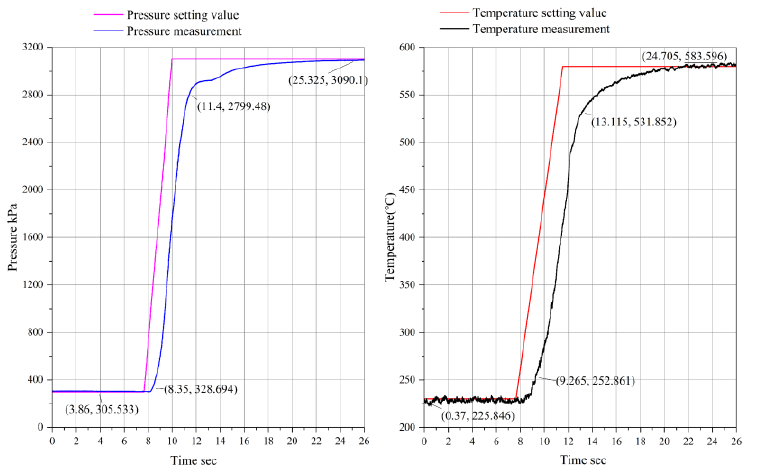
Figure 8. Compressor bleed air simulation of test piece one under the rise rates of 900 kPa/s and 90 °C/s.